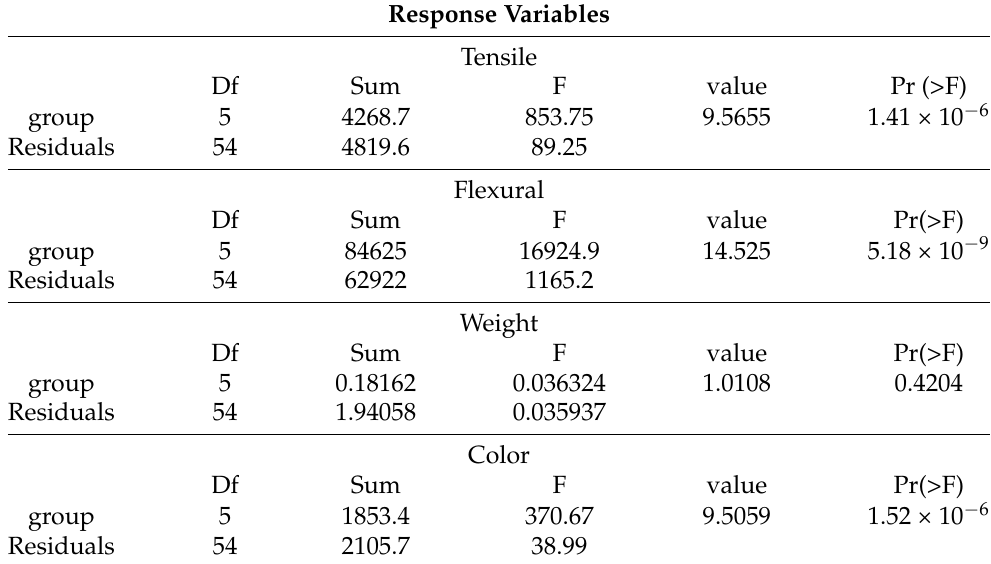
Table 3. Individual variables’ analysis of